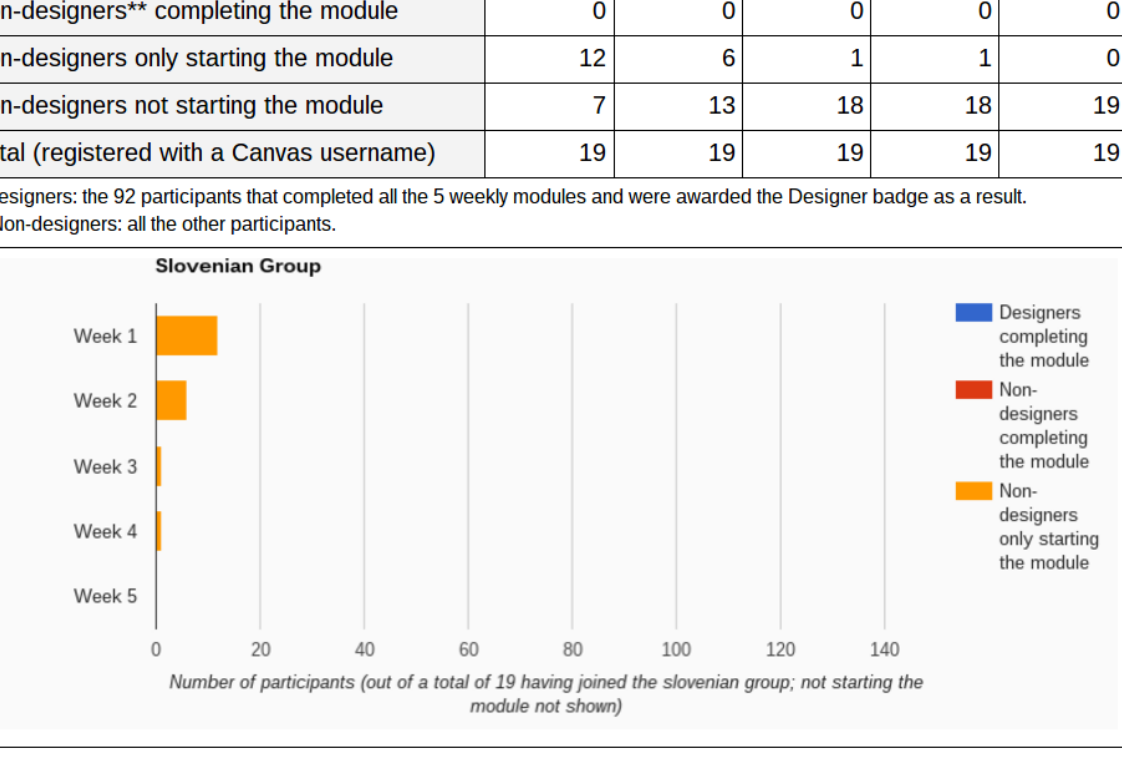
Figure 8. Slovenian group: Participation in weekly modules of